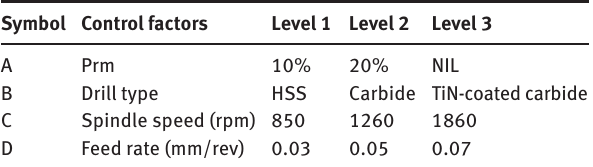
Table 3: Control factors and their levels.